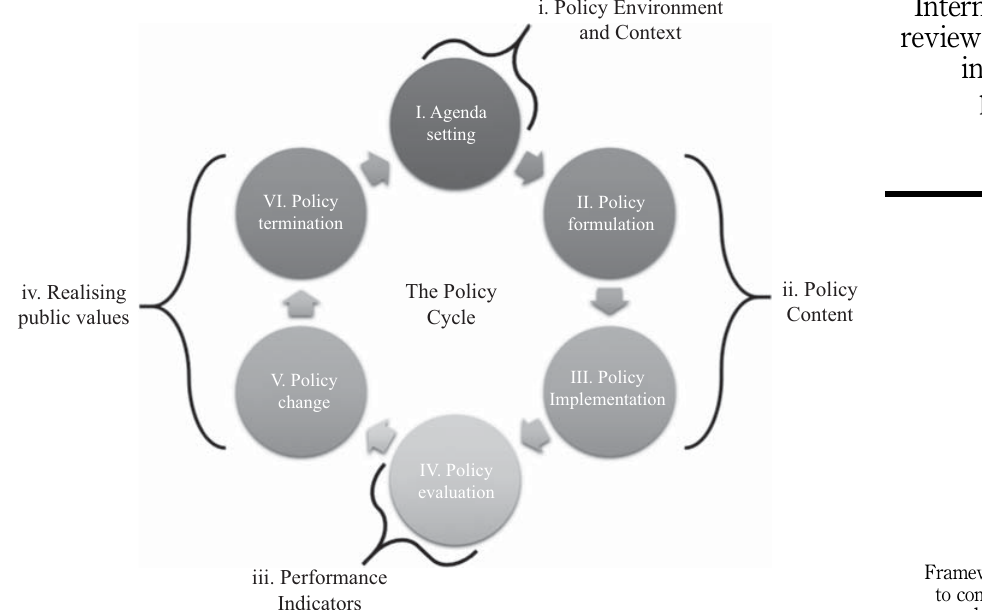
Figure 1. Frameworks